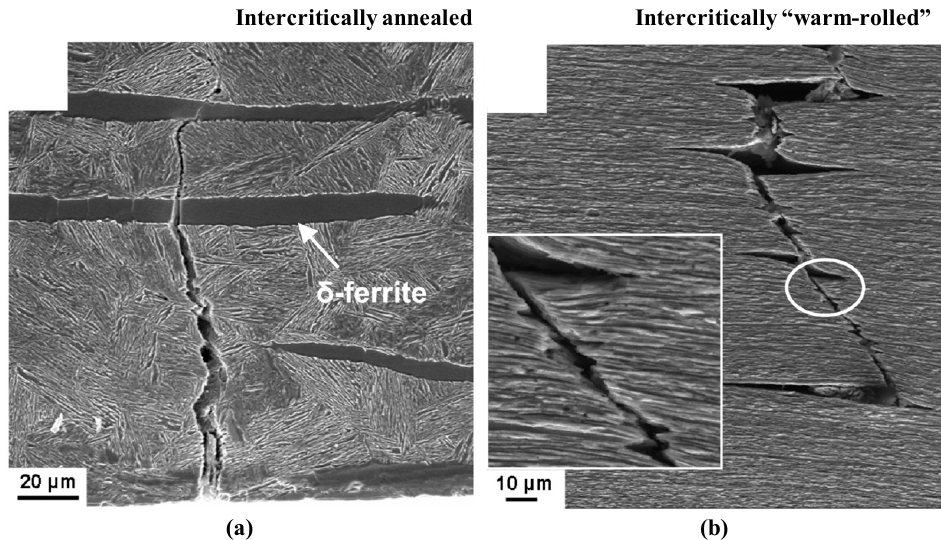
Figure 9. SEM fractographs of H–charged SSRT specimens of ( a ) an intercritically annealed and ( b ) an intercritically warm-rolled medium–Mn steel (Fe–0.20C–4.9Mn–3.1Al–0.6Si, in wt pct). Reproduced from Reference [50], with permission from Elsevier.